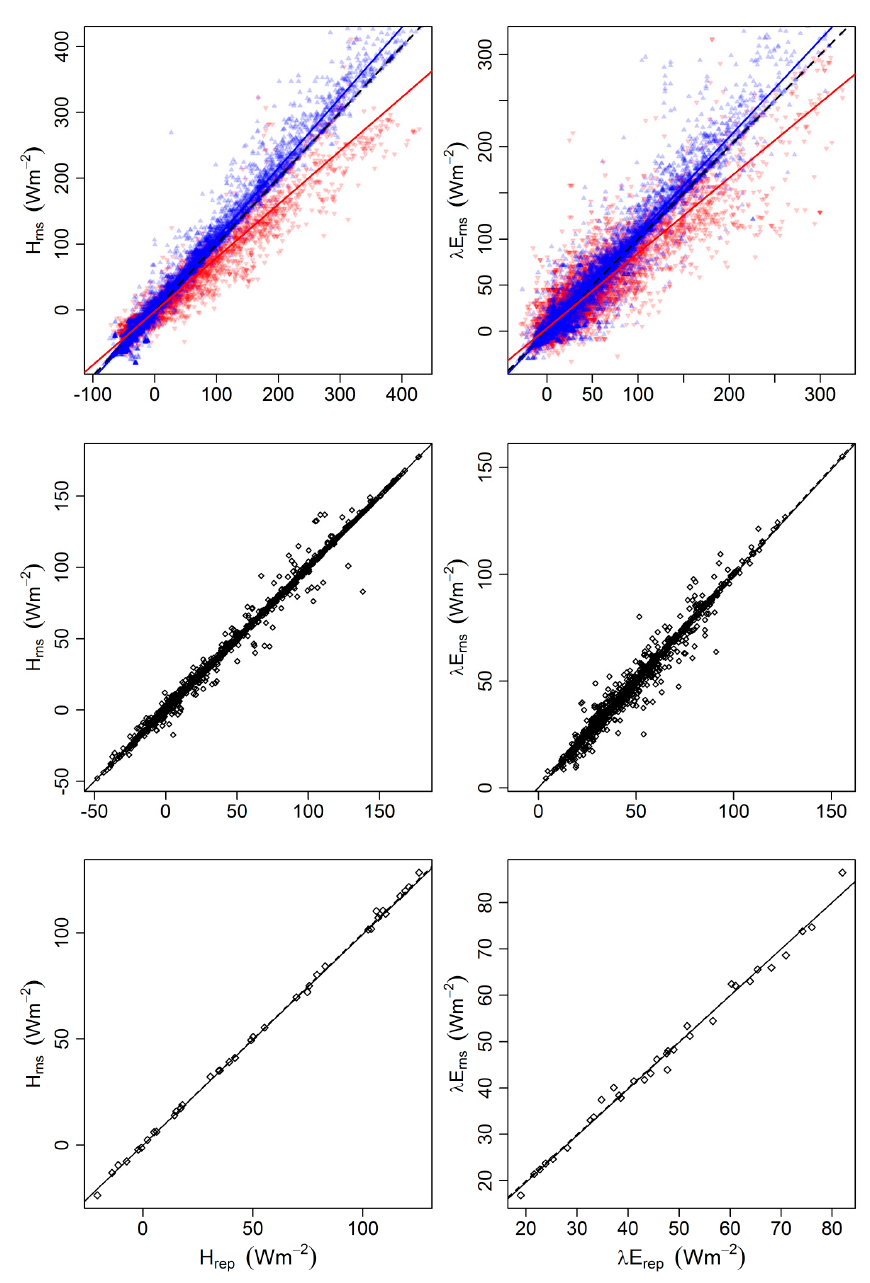
Figure 4. Comparison of the fluxes estimated by REddyProc applied after separating the wind directions (RNS) vs. without separation (REP). Left column: sensible heat fluxes (H); Right column: latent heat fluxes ( λ E); First line: hourly fluxes (30-min intervals); fluxes under NW winds are in blue; fluxes under S winds are in red; Second line: Fluxes integrated at daily time scale; Third line: fluxes integrated at monthly time scale; Continuous lines: regression lines; Dashed lines: 1:1